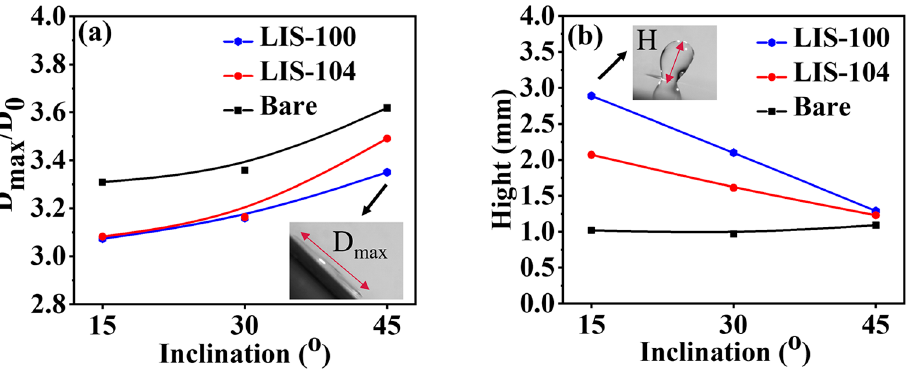
Figure 8. ( a ) Variation in maximum spreading factor (D max /D 0 ) at 3.5 ms and ( b ) bounding height at 15.5 ms with different inclinations for bare, LIS-100 and LIS-104.